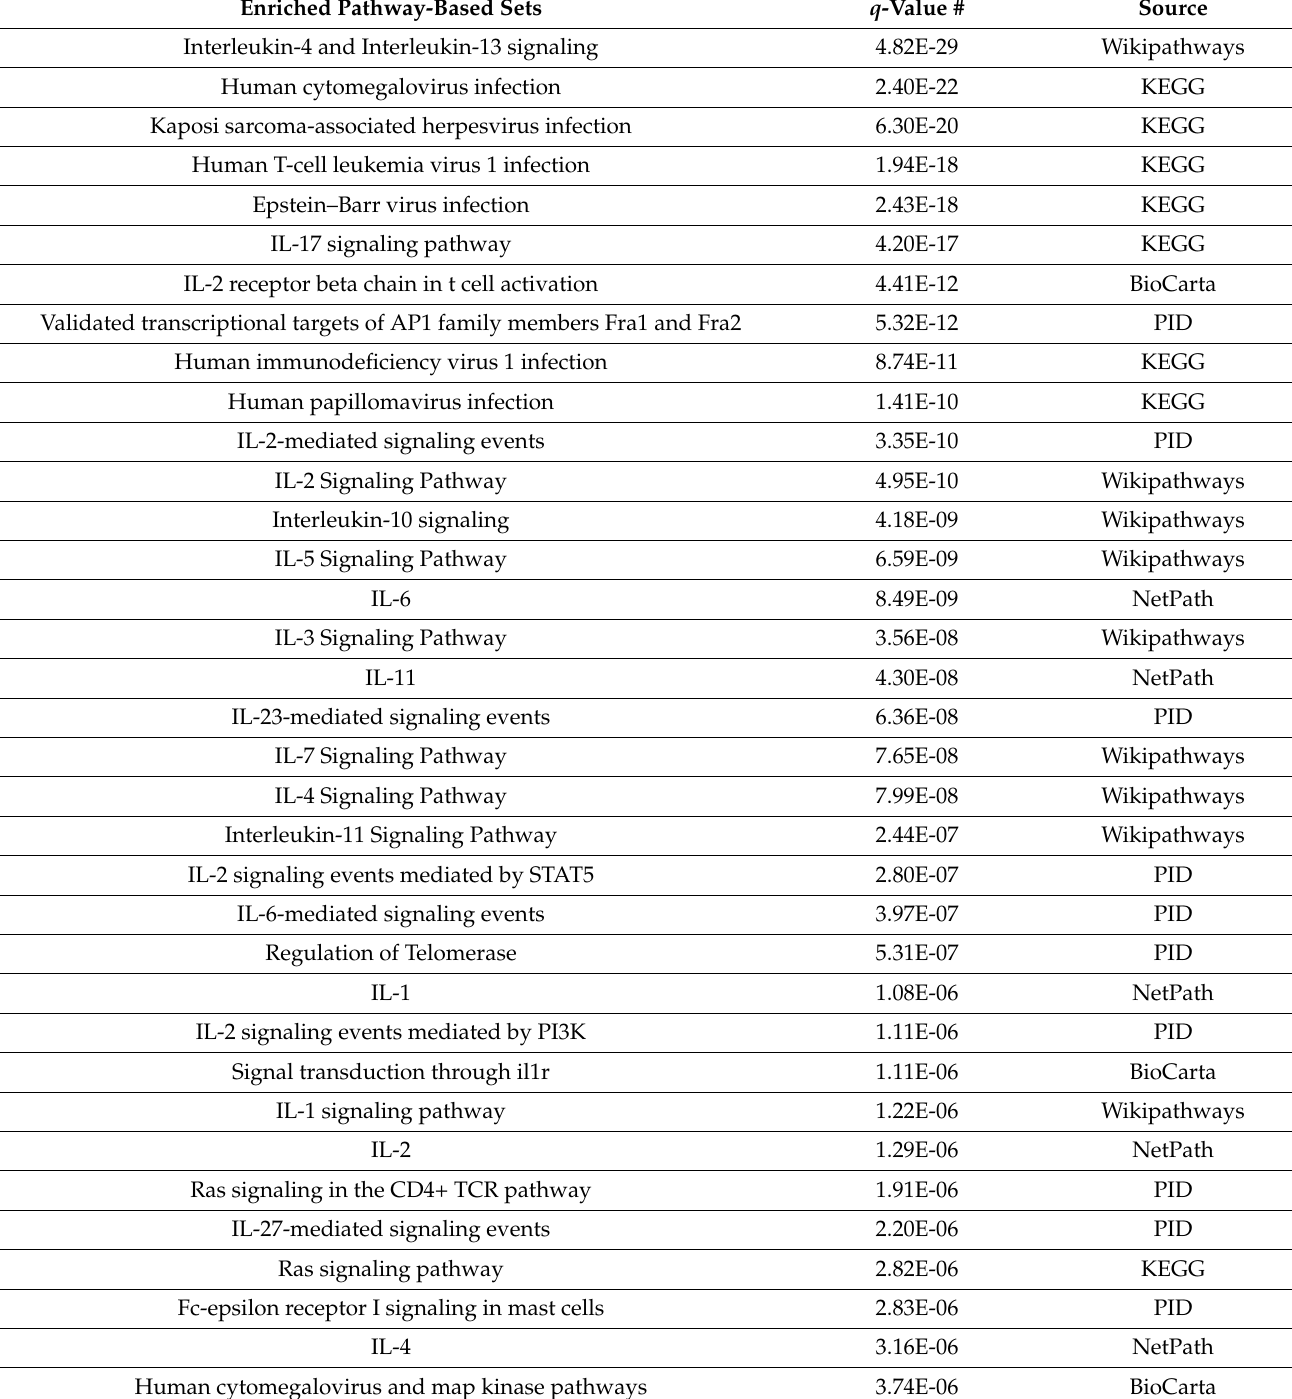
Table 1. The canonical pathway analysis by ConsensusPathDB (CPDB) §